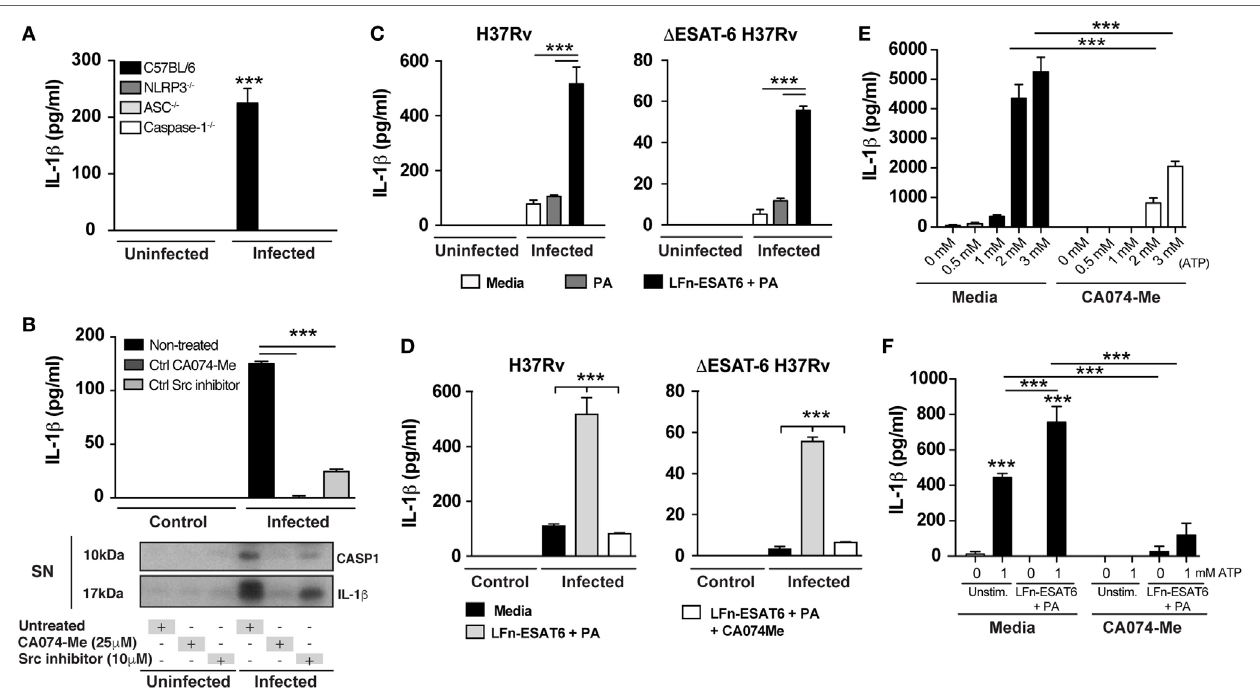
FigUre 3 | Mycobacterium tuberculosis (Mtb) ESAT-6-induced IL-1 β production is diminished by cathepsin B inhibition. Macrophages were infected with Mtb H37Rv or Δ ESAT6 strains at MOI of 3 as described in Section “Materials and Methods.” (a,B) IL-1 β production was measured in the supernatants collected from Mtb-infected deficient macrophages or following different treatments as indicated. (B) Mature IL-1 β and cleaved caspase-1 were analyzed by western blotting. (c,D) Infected macrophages were stimulated with PA (20 µg/mL) or LFn-ESAT6/PA (20 µg/mL) and IL-1 β production was quantified by ELISA after 24 h of infection. (e,F) Bone marrow-derived macrophages were primed with LPS (0.2 µg/mL) for 1 h and further stimulated or not with LFn-ESAT/PA (10 µg/mL each) for 3 h. Furthermore, cells were stimulated with eATP (1 mM) for 25 min and IL-1 β production was measured in culture supernatants. Statistical differences observed are shown for each indicated groups (*** p < 0.001). The data represent the mean ± SEM of samples in triplicate. Data are from at least three independent